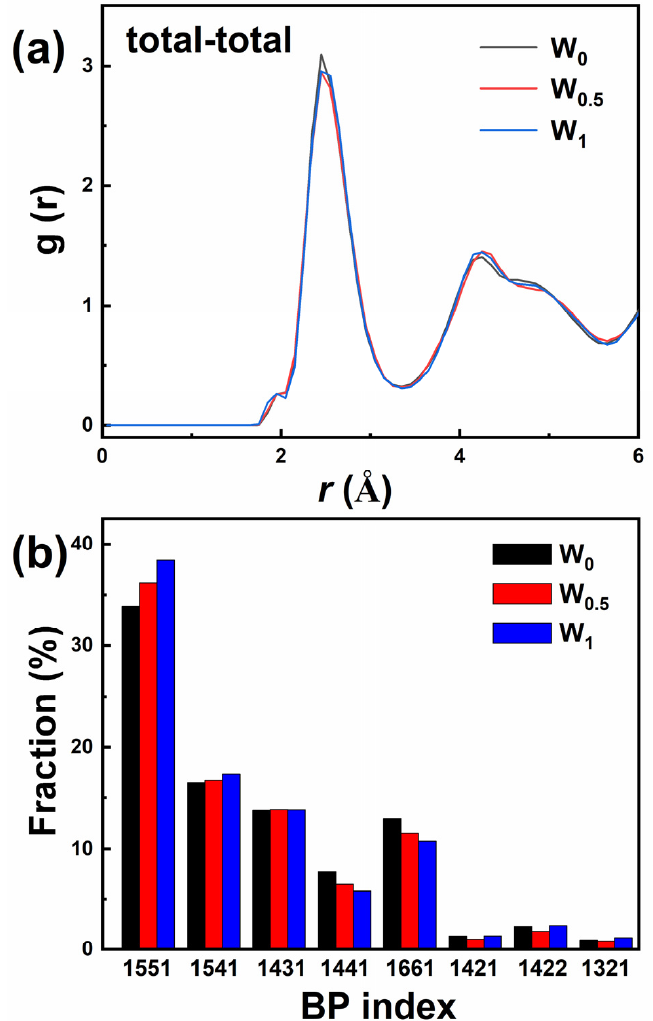
Figure 6. ( a ) Pair correlation functions and ( b ) bond pairs distribution of Fe 86 − x P 11 C 2 B 1 W x (x = 0, 0.5, and 1) amorphous alloys.